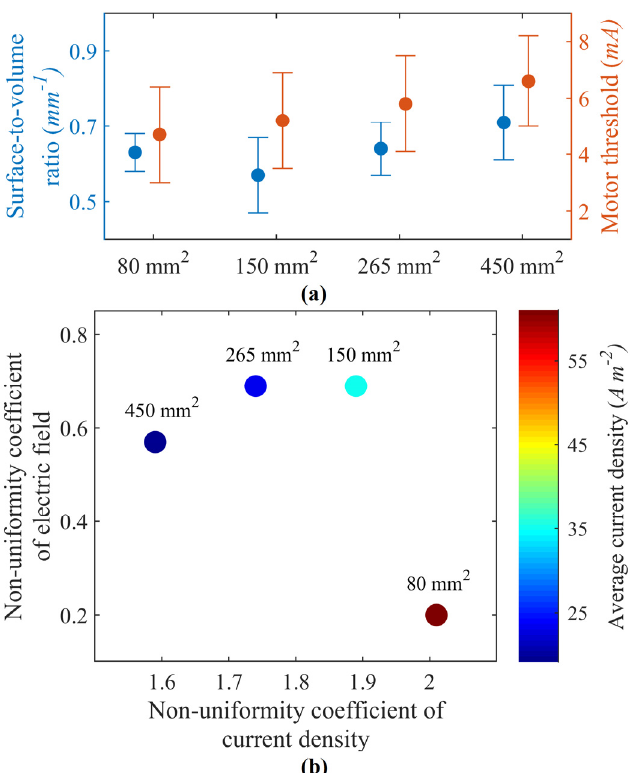
Figure 2. ( a ) Motor thresholds and normalized surface-to-volume ratios for respective activation volume. The error bars represent values for motor nerve stimulation at depths of 12.4, 14.6, and 16.8 mm. ( b ) Plot comparing model-predicted nonuniformity coefficients of current density and electric fields for electrodes with different surface areas. The color bar represents the average current den- sity.